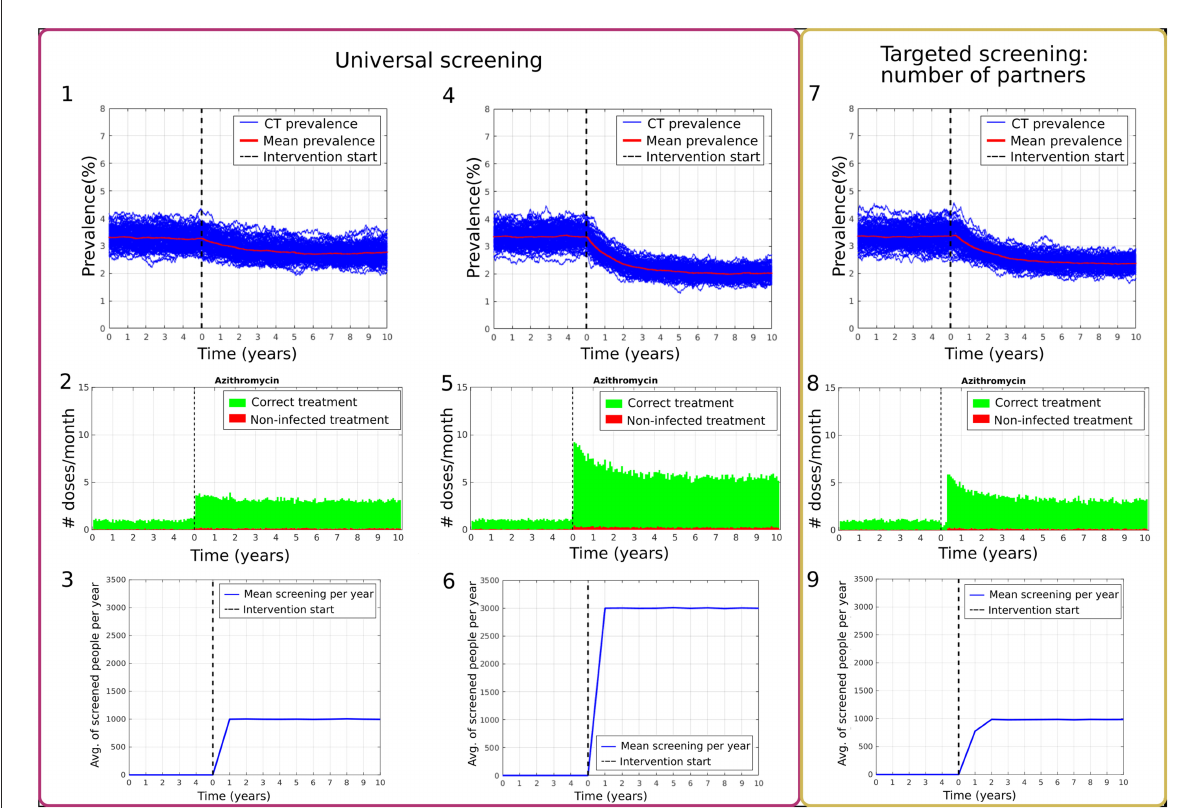
FIGURE1 Comparison of program effects between universal screening with 10% and 30% of the population screened per year ( 1–3 and 4–6 respectively) and targeted screening according to the number of partners with 10% of the population screened per year (7–9) . (1,4,7) show prevalence results over 100 simulations (blue) and the mean percentage of prevalence (red). (2,5,8) present t the number of doses provided per month, where the individual had a chlamydia infection (green) or was not infected (red). (3,6,9) show the average number of people screened per